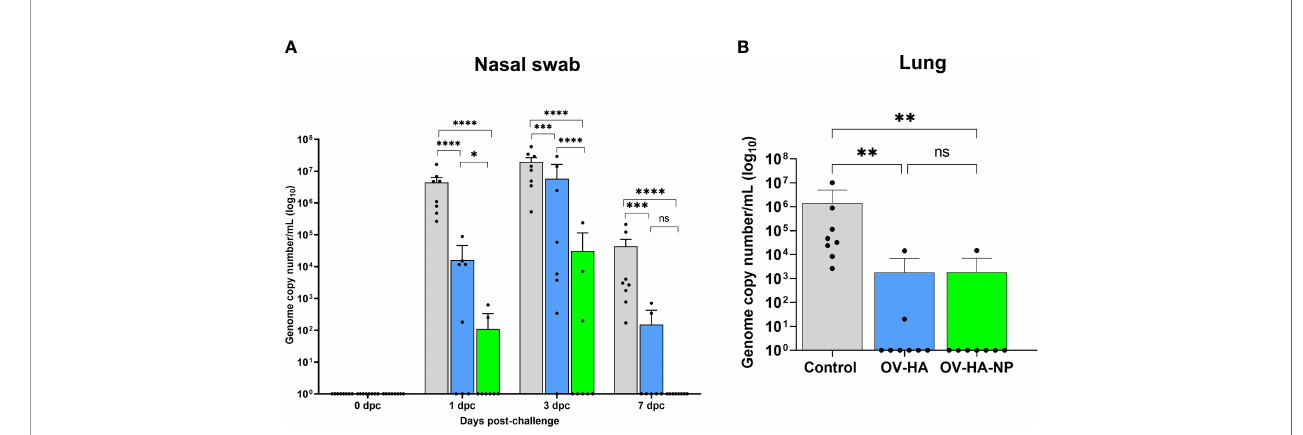
FIGURE 6 | Protective ef fi cacy of OV-HA and OV-HA-NP against IAV-S challenge. (A) IAV-S viral RNA shedding in the nasal swab was determined by RT-qPCR and expressed as log10 genome copy number per milliliter. (B) IAV-S viral load in the lung determined by RT-qPCR and expressed as log10 genome copy number per milliliter. Data represents group mean and error bars represent SEM. P-values: *P < 0.05, **P < 0.01, ***P < 0.001, ****P < 0.0001; ns, non-signi fi cant.